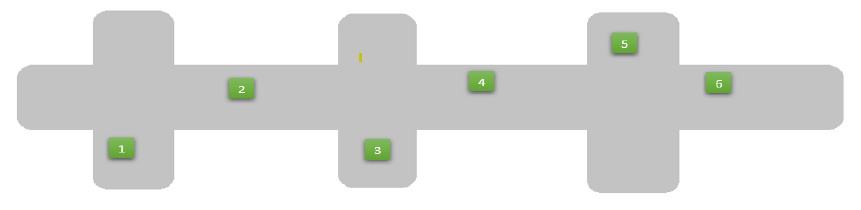
Figure 1. Road network with